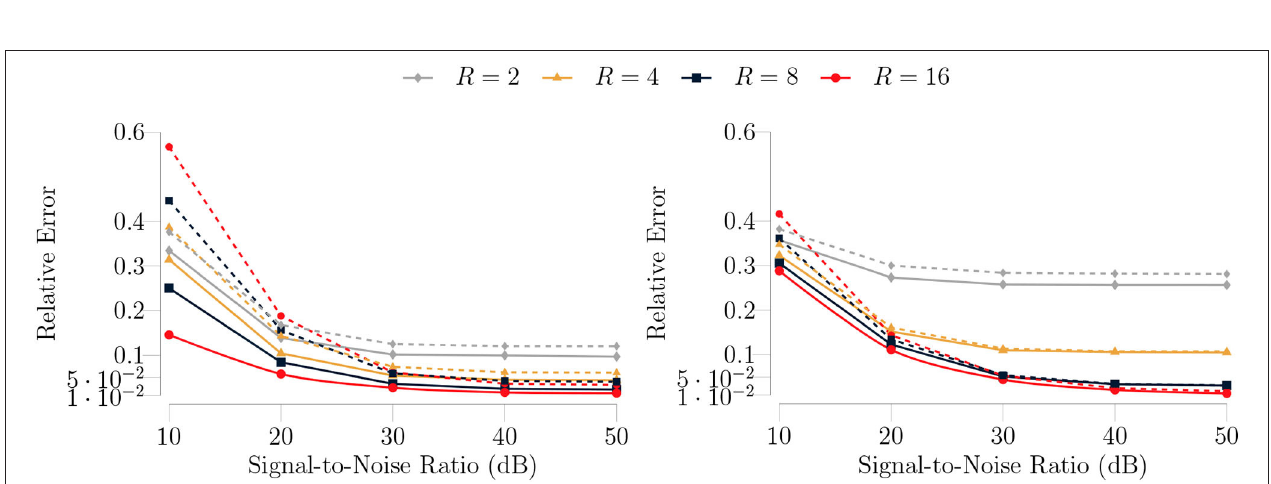
FIGURE 3 | (Left) The median test (dashed lines) and training (solid lines) errors of the type I model for 100 trials on the synthetic data for a rank-8 function given as in Equation (28). The number of samples for the training dataset is set to 5,000 and for the test dataset it is set to 1,000. The batch size is set to 500 and the maximum number of GN iterations is set to 5. (Right) The median test (dashed lines) and training (solid lines) errors of the type II model with the same algorithm settings. TeMPO produces more accurate results and generalizes better for higher rank values for both the type I and type II model. The performance is robust to overparameterization ( R > R f ). The type I model produces better results for low rank values, i.e., R < R f .